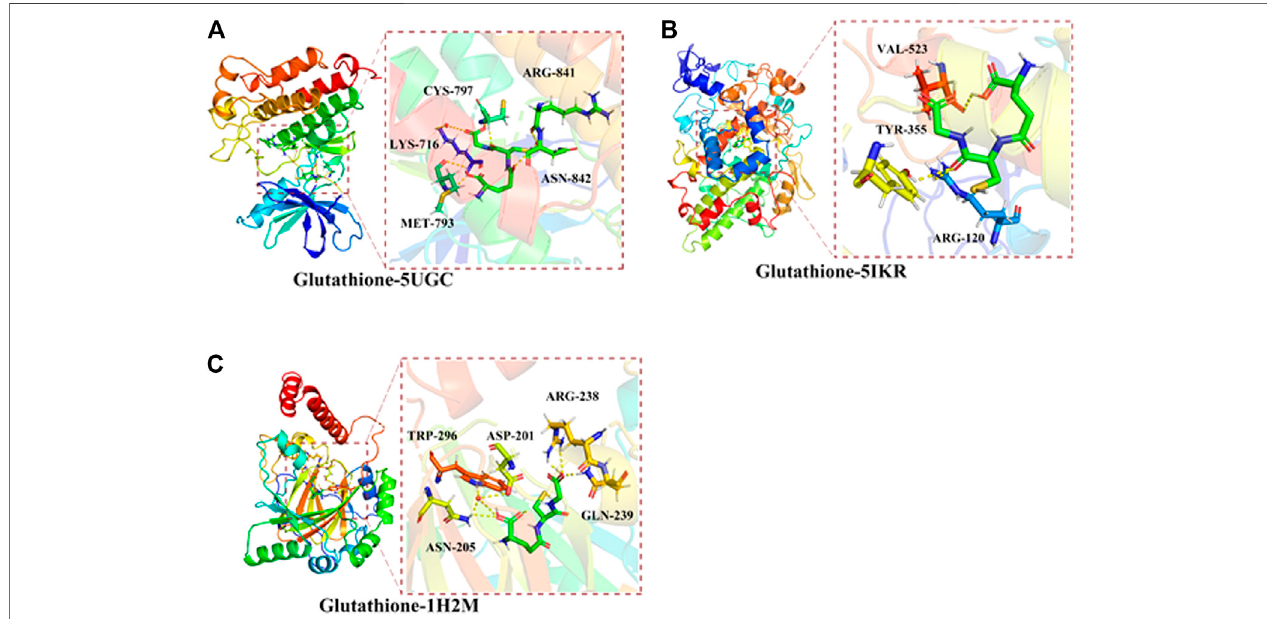
FIGURE3| Directbindingofglutathione(GSH) toitstargets againstoralcancerthroughferroptosis.Moleculardocking analysispredictedthepreferredorientation of hydrogen bonds between GSH and amino acid residues (A) CYS-797, MET-793, and LYS-716 of EGFR (PDB ID:5UGC) (B) TYR-355, ARG-120, and VAL-523 of PTGS2 (PDB ID: 5IKR) (C) ARG-238 and GLN-239 of HIF1A (PDB ID: 1H2M).